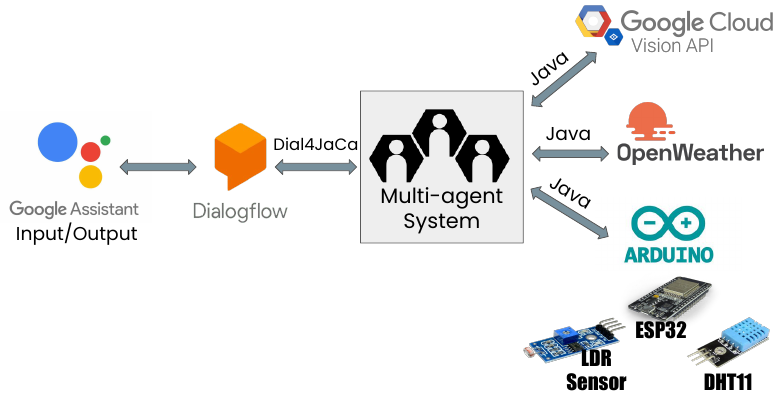
Figure 2. High-level view of our